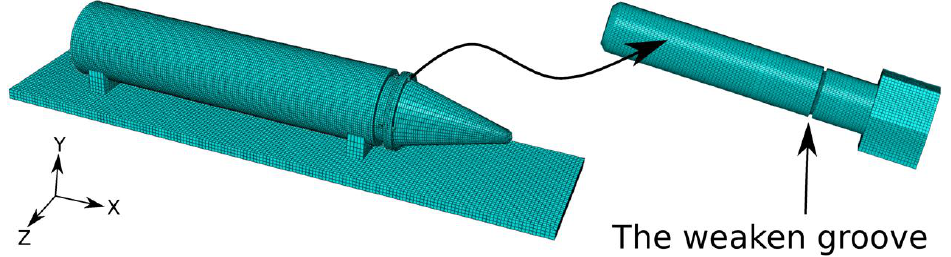
Figure 5. Meshes of the half missile model. Table 2. Properties and meshes of the half missile model.